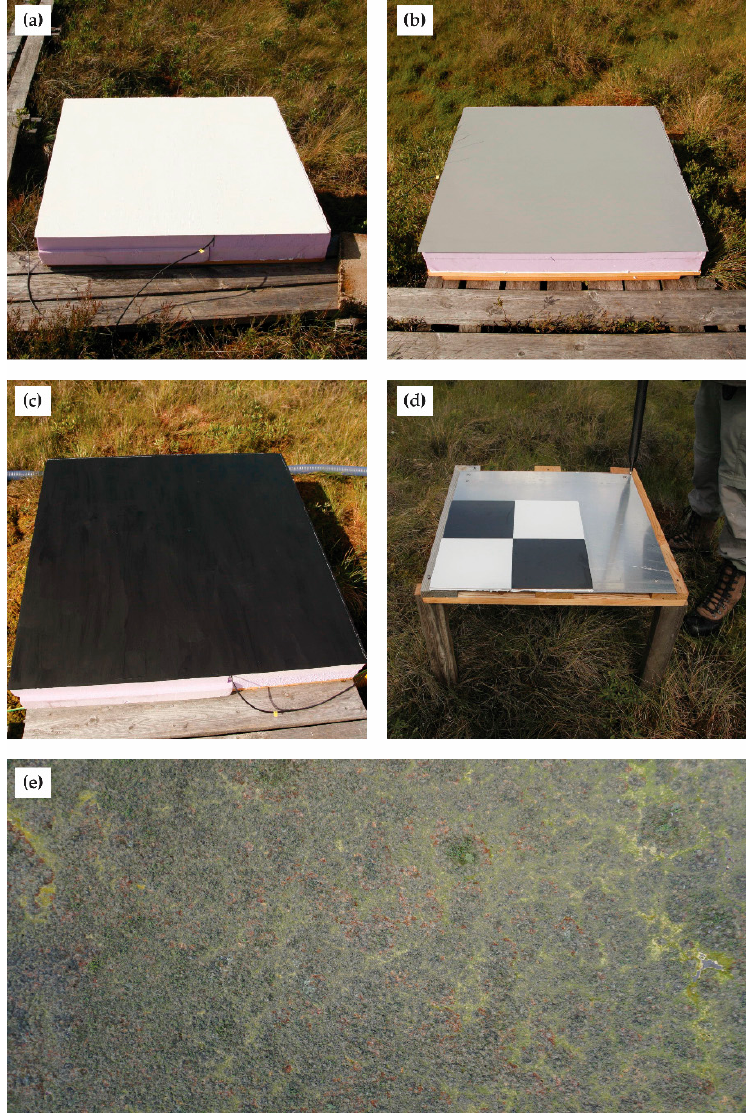
Figure 1. ( a – c ) Photos of the temperature calibration plates (TCP) used for radiometric calibration, ( d ) photo of a ground control point (GCP) used for georectification, ( e ) photo of mire vegetation taken during a UAV flight in June 2017. Using tiles on top of the aluminum GCP created a distinctive ‘L’ shape that facilitated identification of the corner measured with the RTK-GPS, as shown in (d), and enabled the GCPs to be used for both optical and TIR UAV cameras.